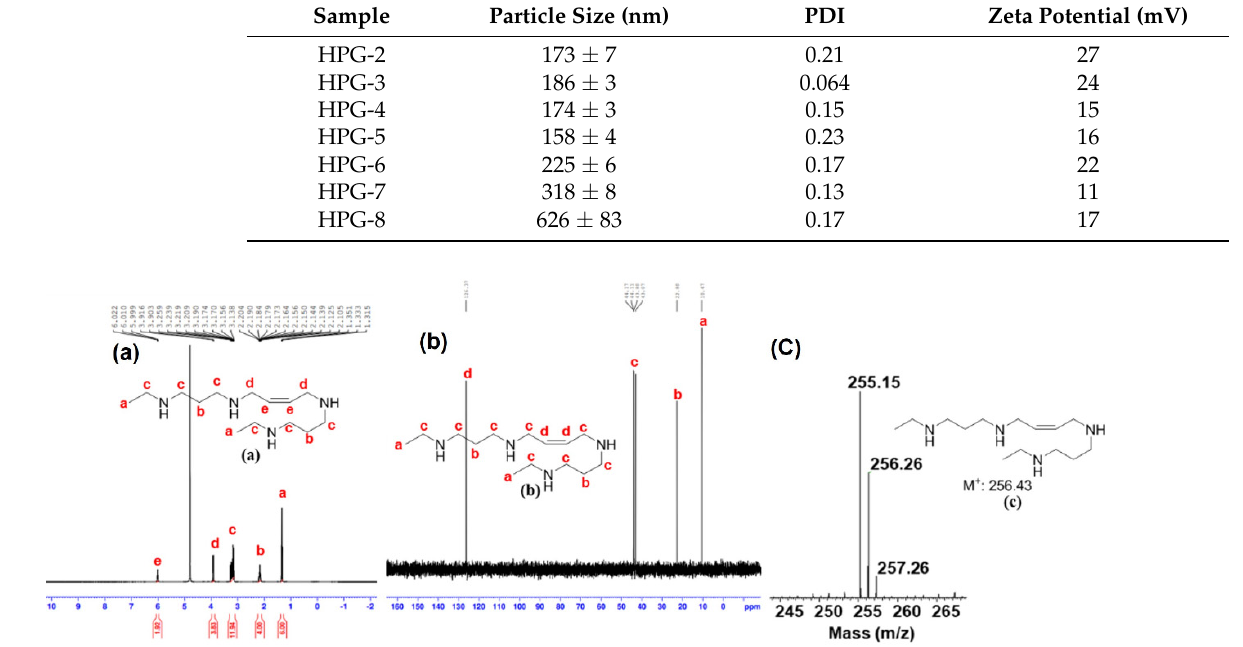
Figure 1. ( a ) 1 H NMR, ( b ) 13 C NMR, and ( c ) mass spectrometric analysis (Orbitrap fusion) of PG11047 (HPG-1).